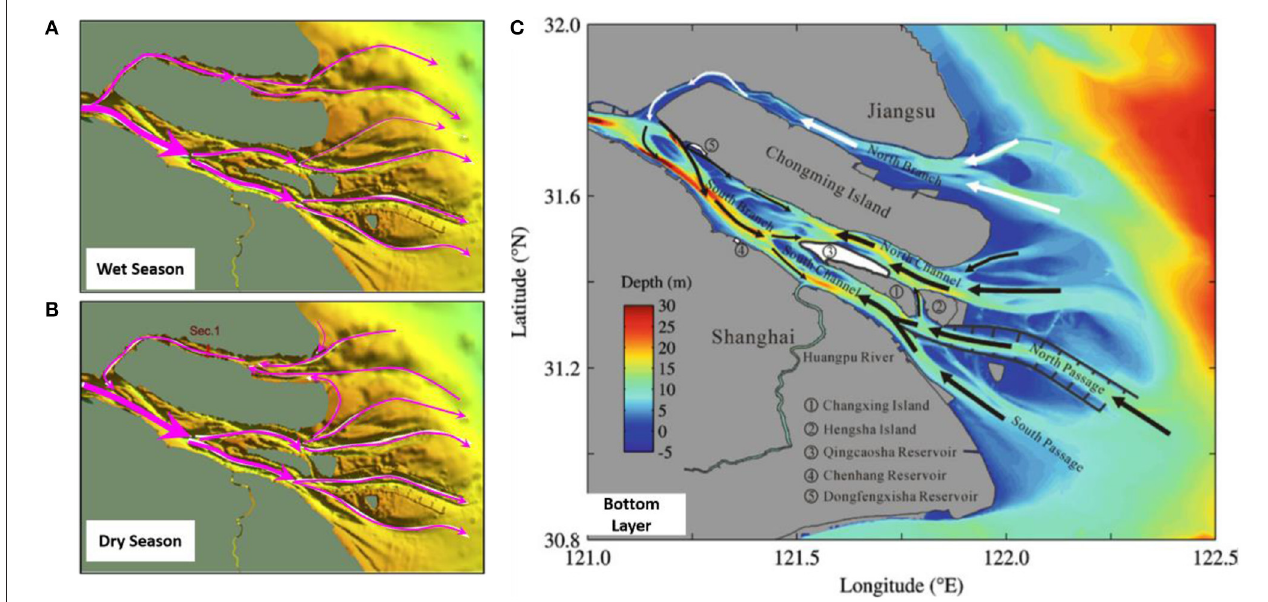
FIGURE 2 | Schematics of the subtidal flow patterns (Xue et al., 2009) during (A) wet and (B) dry seasons, and (C) pathways for saltwater intrusion (arrows) (Zhu et al., 2015 ), with the white and black arrows in (C) denoting pathway of the onshore invading shelf